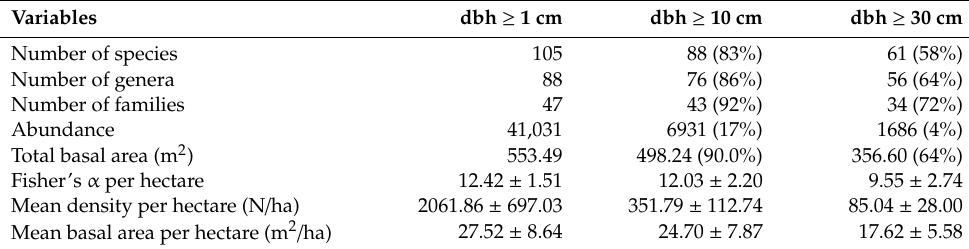
Table 1. Tree abundance and diversity in the 20.28-ha Ngel Nyaki Plot, in three diameter at breast height (dbh) categories. Mean values and standard deviations are presented for per hectare estimates.